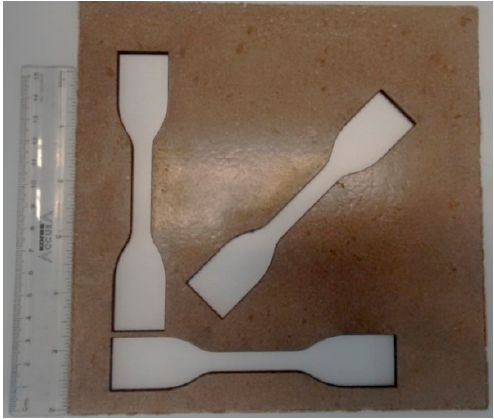
Figure 1. Image showing the cut out of the samples in three different directions.